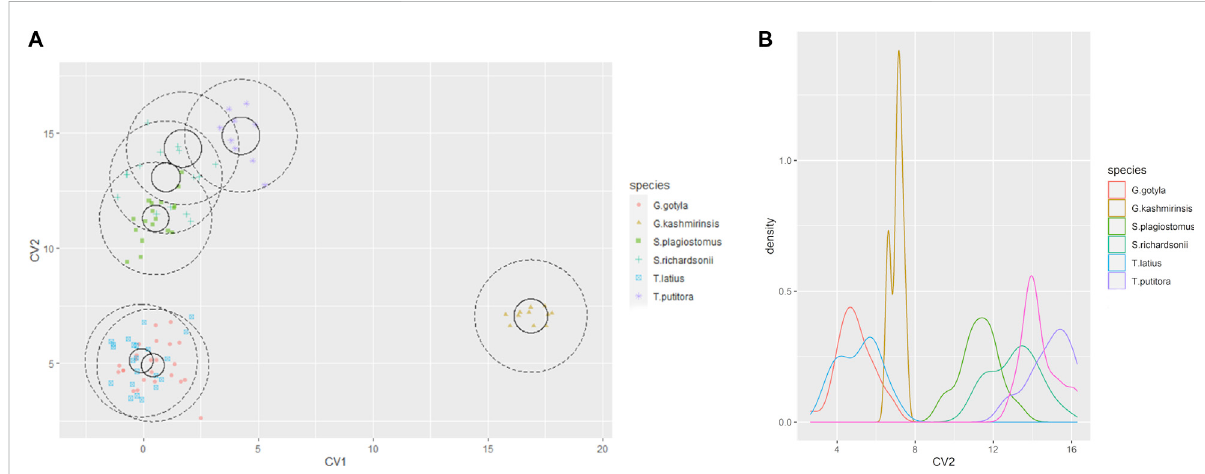
FIGURE 3 (A) The Canonical Variate (CVA) showing the morpho-genetic variation of six fi sh species collected from River Poonch (B) biplot of same centroids of the canonical variate score are shown on the 25 morphometric distances.